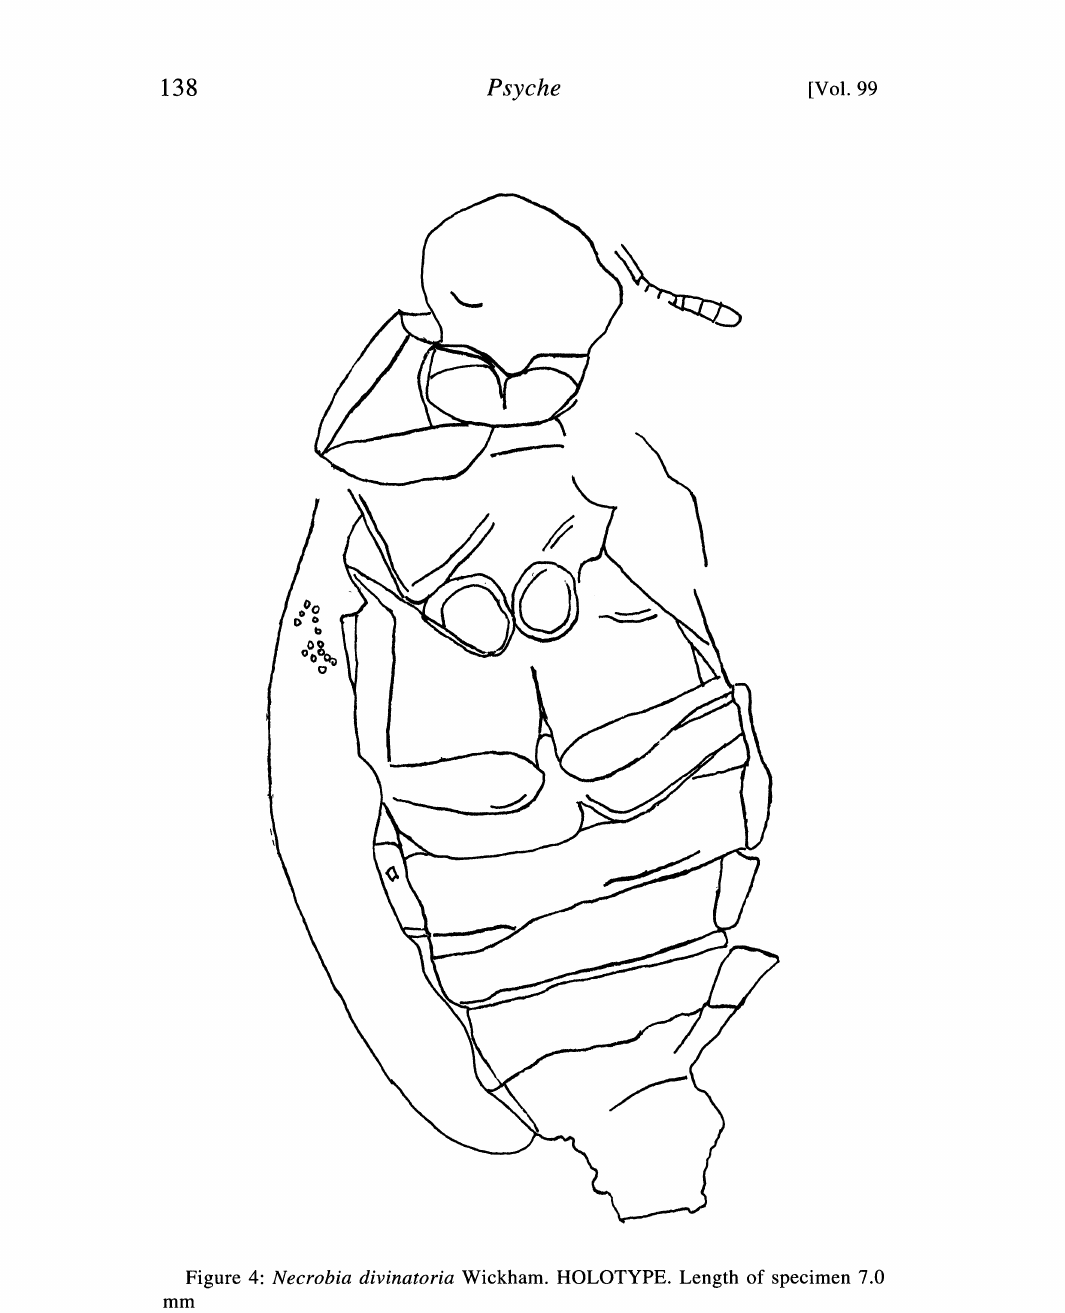
Figure 4: Necrobia divinatoria Wickham. HOLOTYPE. Length of specimen 7.0